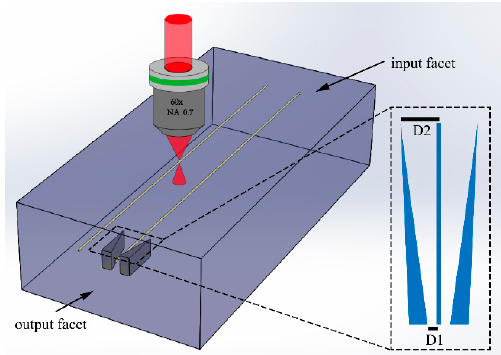
Figure 1. 3D sketch of the femtosecond-laser direct-writing waveguides and the tapered modification structures. Inset: top view of the waveguide and tapered structure. D1 and D2: distances between the modification structure and the waveguide at the wider and the narrower ends of the taper respectively.